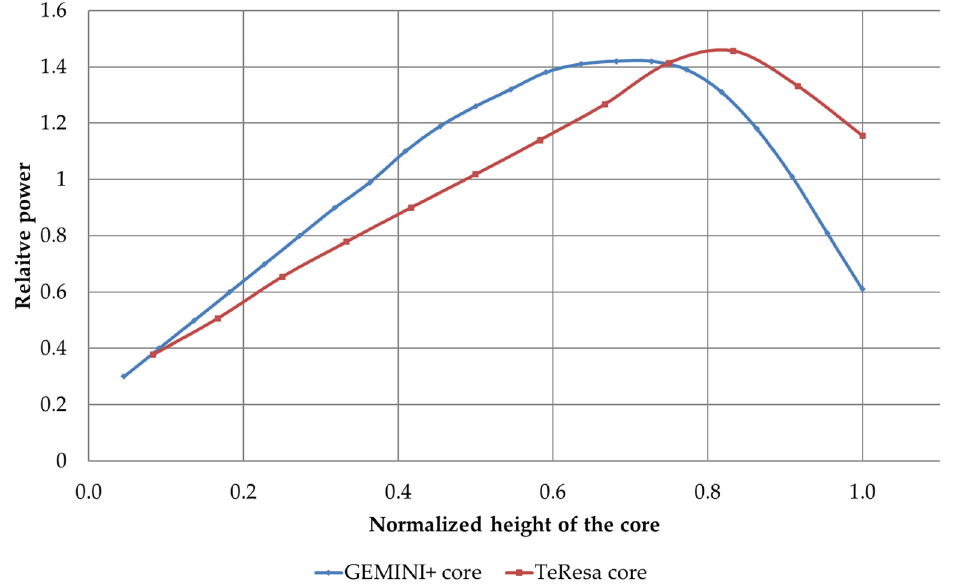
Figure 4. The comparison of the axial power distribution for GEMNI+ and TeResa core.